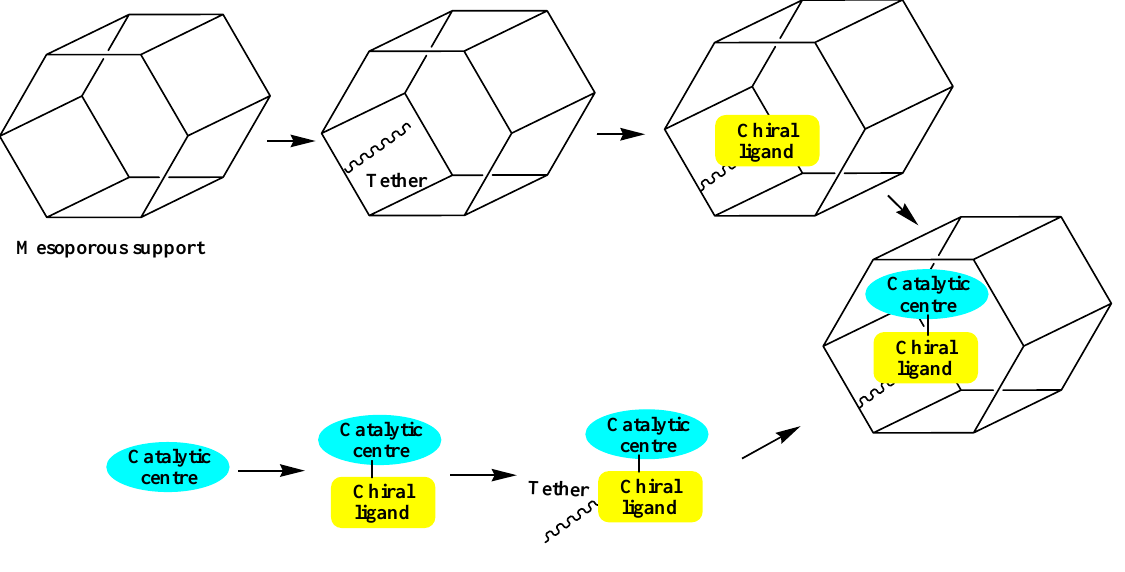
Figure 12. Two distinct approaches to anchor catalytically-active chiral metal complexes onto silica-based molecular